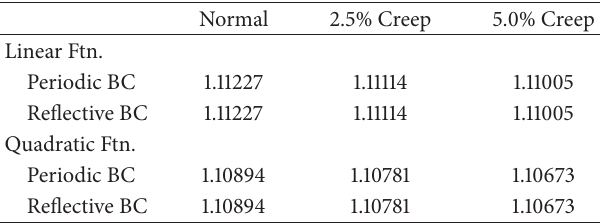
Table 3: Multiplication factors of the TRIAINA-P3